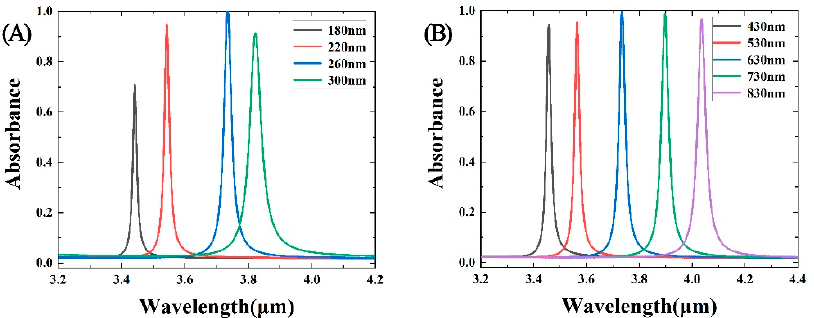
Figure 6. Parameters of the width of symmetrical Si grating ( A ) and thickness of symmetrical Si grating ( B ).